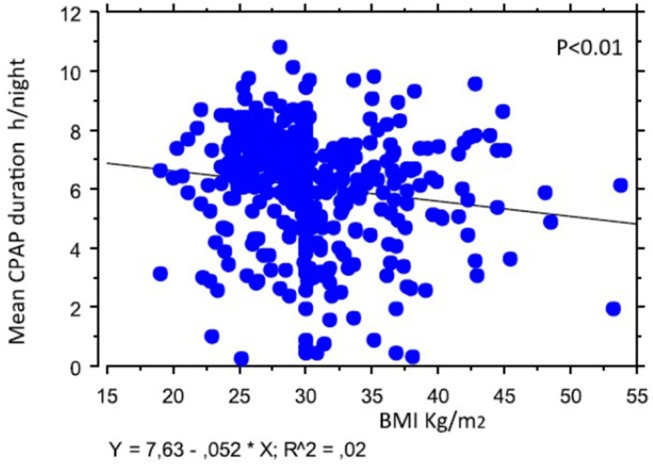
Linear regression analysis testing the relationship between mean nocturnal CPAP duration and body mass index at the inclusion in the study.